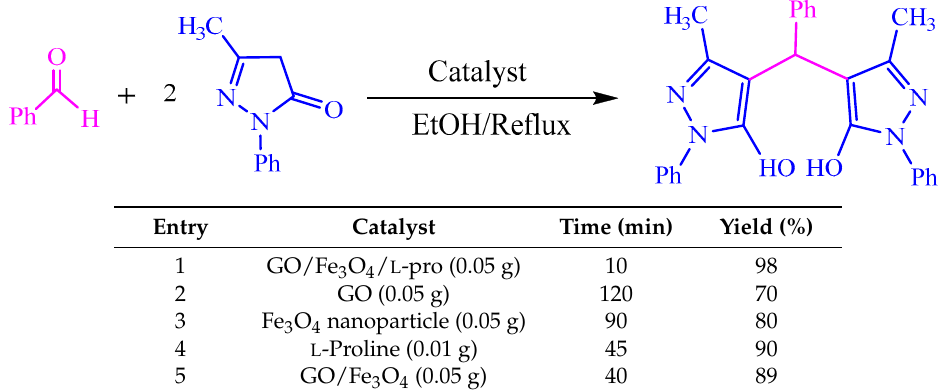
Table 3. Catalytic activity of GO/Fe 3 O 4 / L -proline nano hybrid in comparison with pure GO, Fe 3 O 4